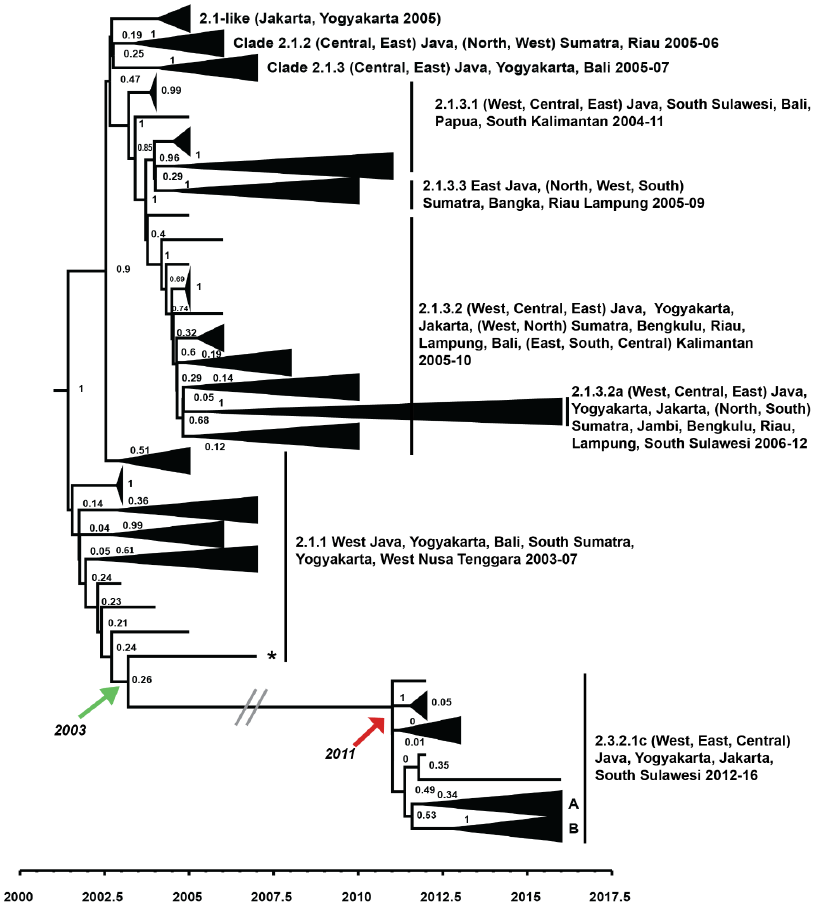
Figure A1. Time-measured phylogeny of HA genes of Indonesian poultry HPAIv A(H5N1) 2003–2016. The estimated root of HA clade 2.3.2.1c was highlighted by asterisk symbol, the tMRCA of HA clade 2.3.2.1c is pointed out by the red arrow, and the tMRCA between HA clade 2.1.1 and 2.3.2.1c is pointed out by the green arrow. The HPAIv A(H5N1) clade 2.3.2.1c diverged into subgroups (A and B). The node labels display the posterior value. The two gray lines between the clades 2.1.1 and 2.3.2.1c represent the presence of multiple viruses between these two clades as presented in Figure 2. The original sequences (GISAID ID) of HA genes of Indonesian poultry HPAIv A(H5N1) 2003–2016 phylogeny is displayed in Supplementary Table S1.